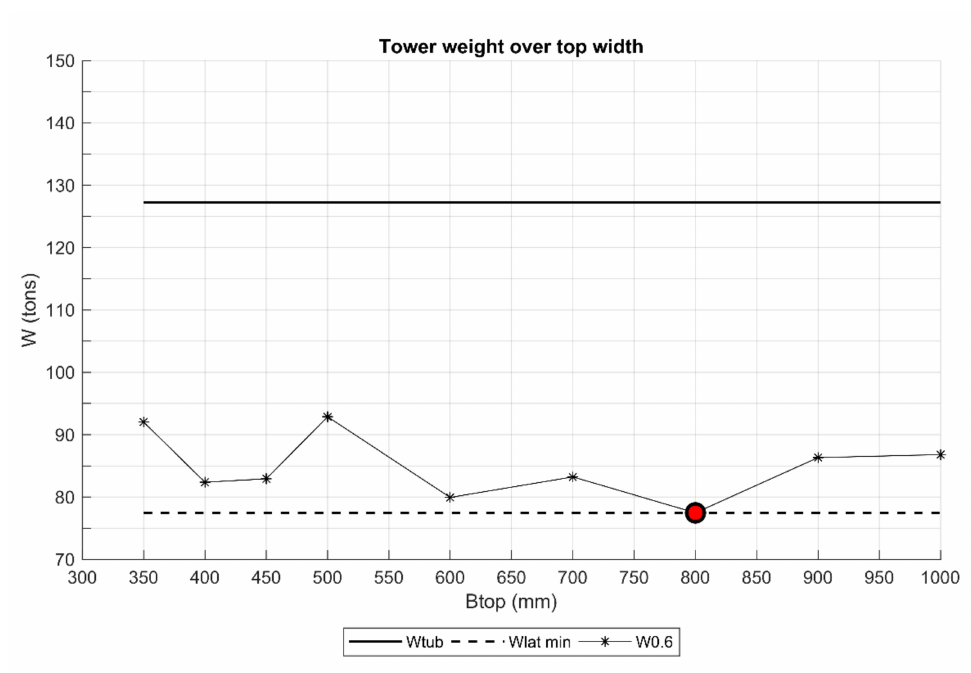
Figure 13. Weight of tower cases for µ = 0.6 in correlation with Btop for the 76 m